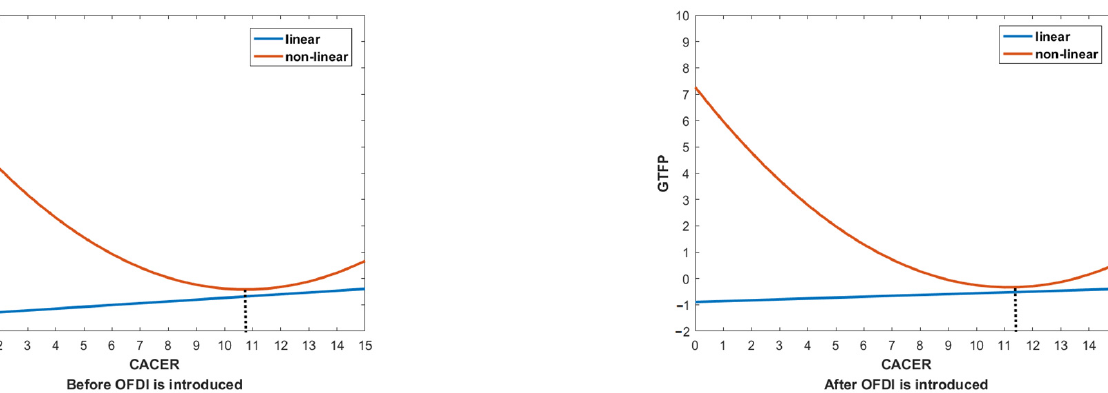
Figure 6. The inflection points for the impact of CACER on GTFP in western China.